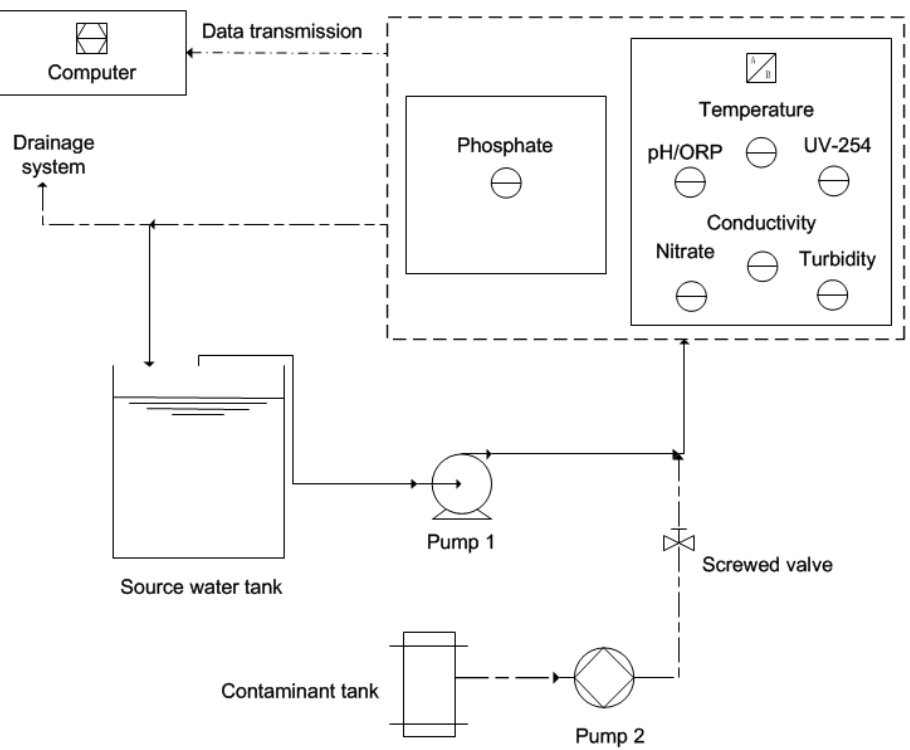
Figure 1. A process flow schematic of the pilot-scale system.